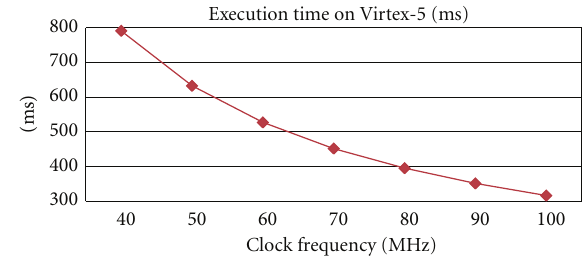
Figure 21: Impact of the clock frequency to the execution time of a uniprocessor design executing the NCC algorithm on a V5LX110T.